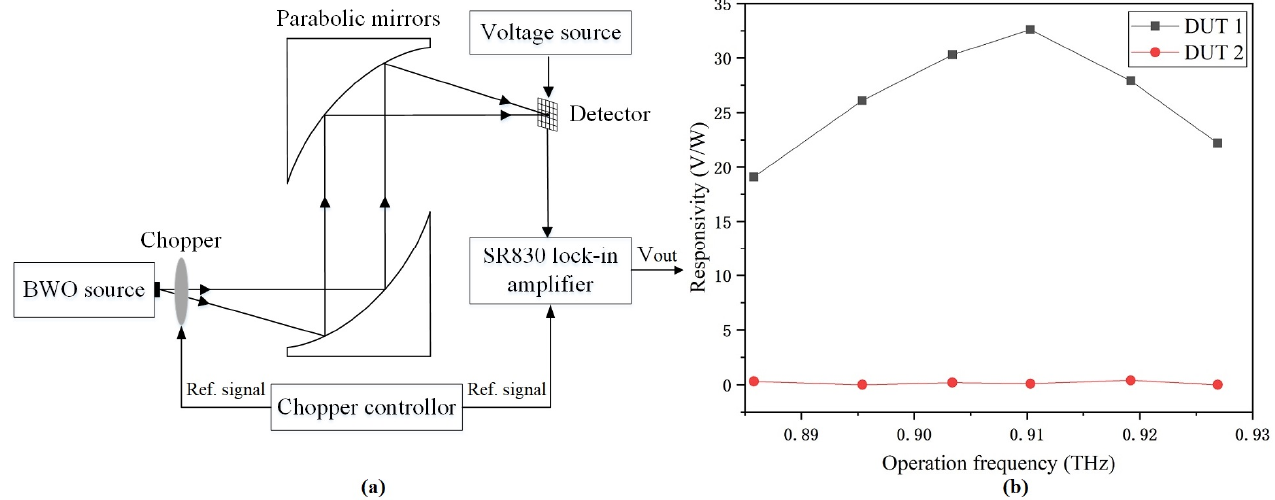
Figure 6. ( a ) Output voltage measurement setup as detectors operate at 0.91 THz. ( b ) Responsivities.